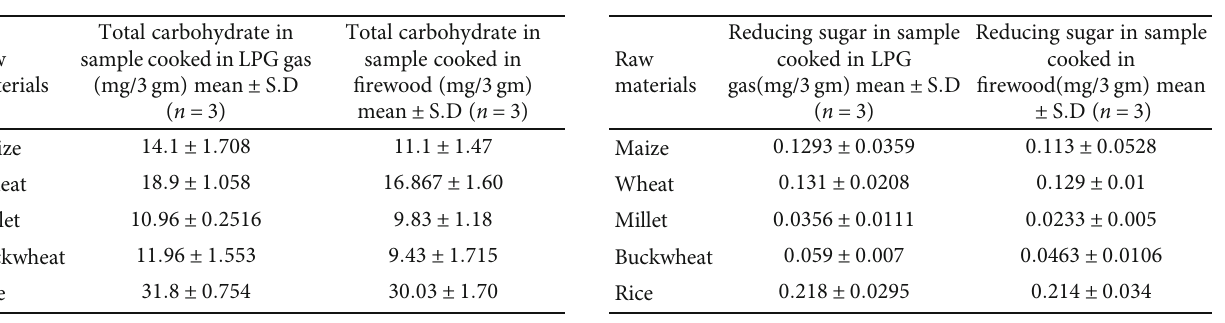
Table 2: Total carbohydrate content in sample cooked in LPG gas and fi rewood.